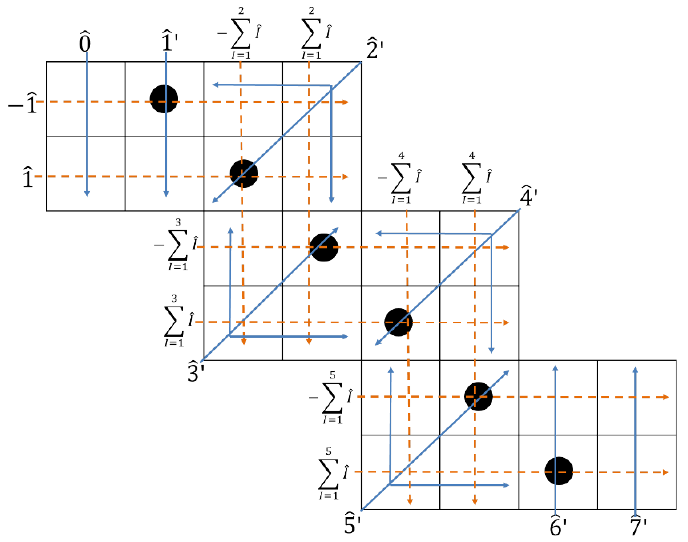
Figure 7 . Similar to (cid:12)gure 5, this (cid:12)gure represents the masses and R-charges of all the hypermul- tiplets. ^ I ab = f Mass ; R ( R ) ; R ( J ) g of every hypermultiplet is given by the sum of the ^ I s that appear on the tail of the arrows crossing the corresponding block where ^ I = f (cid:22) 0 and ^ I 0 = ^ I + f 0 ; 0 ; 2 k I g . Notice that P M +1